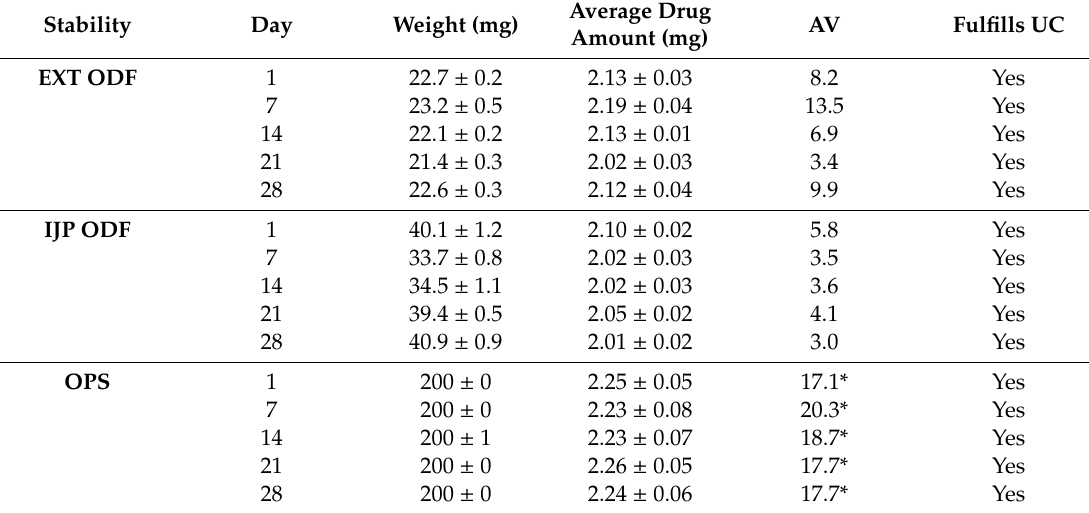
Table A5. The drug amount, acceptance value (AV), and uniformity of content of single-dose preparations (test B) (UC) of the manufactured dosage forms during the stability study. Results are presented as average ± SD, n = 10. No further testing of an additional 20 dosage forms in case the batch failed to comply with the requirements stated in the Ph. Eur. was carried out, however, the batches that could have been further tested to determine if the batch pass or fail are marked with